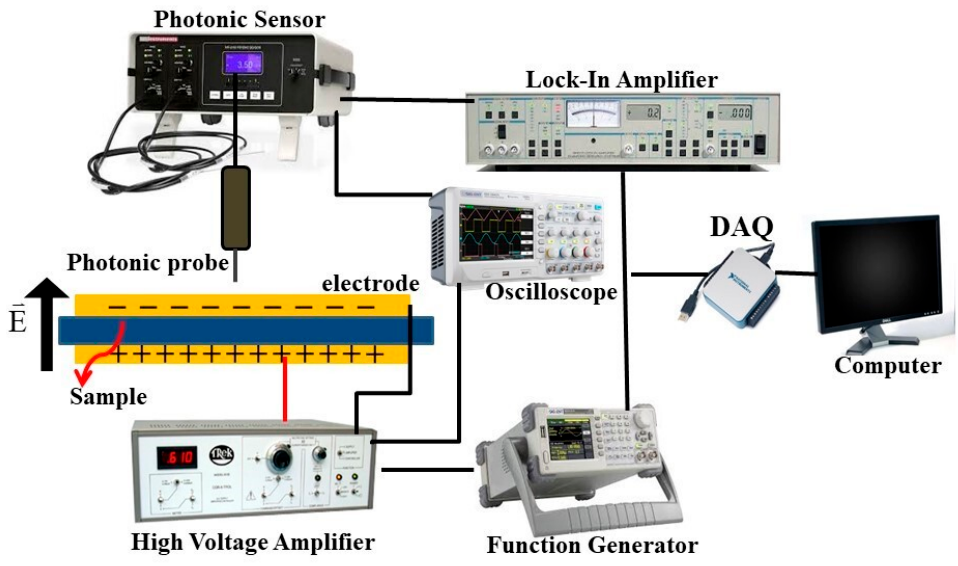
Figure 2. The electrostrictive measurement